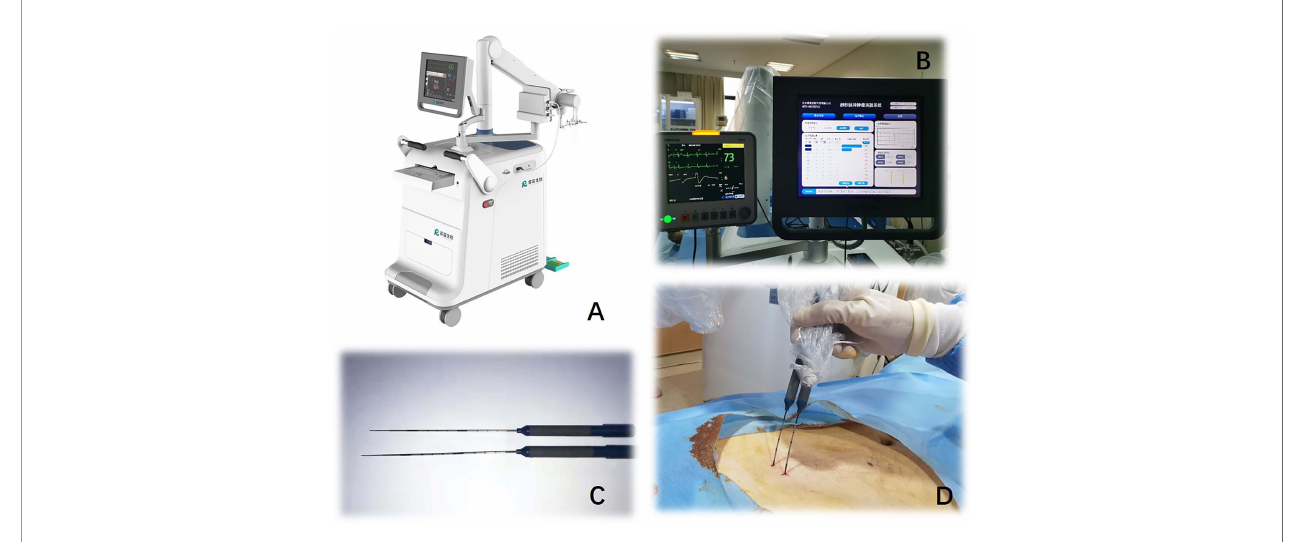
FIGURE 3 | Nanosecond pulsed electric fi eld equipment (Hangzhou Ruidi Biotech Ltd, Hangzhou, Zhejiang, China) (A) console. (B) displayer. (C, D) 19G monopolar needle